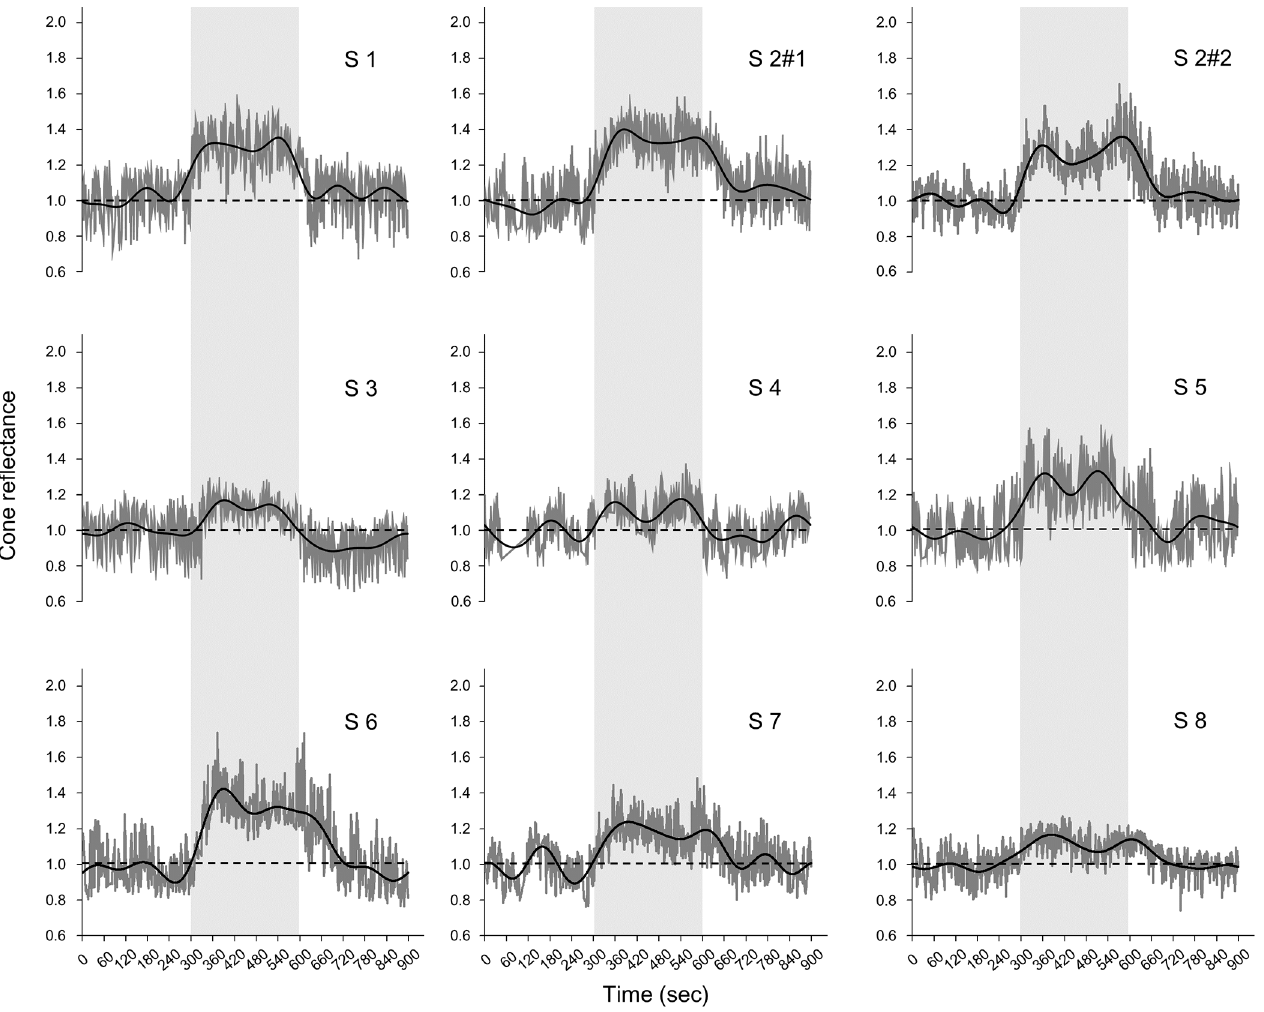
Fig 4. Reflectance changes at 3° temporal from the fovea. The dark gray lines indicate the reflectance changes at 3° temporal from the fovea. The black line shows the low-pass filtered data at 0.008-Hz. The dotted line indicates the baseline. The light gray zone indicates the period of light stimulation. Cone reflectance increases during light stimulation and has two peaks in all subjects. Subject 2 underwent the repeatability experiments (S2 #1 and S2